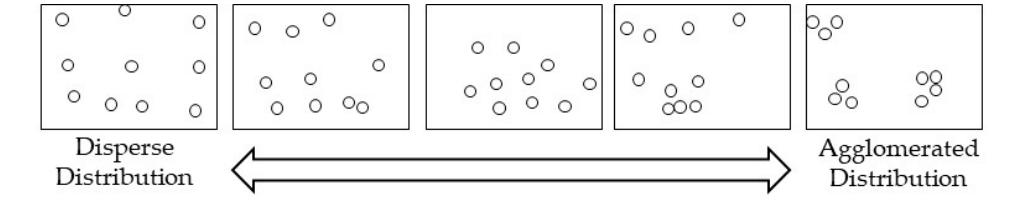
Figure 1. Type of spatial point distribution.